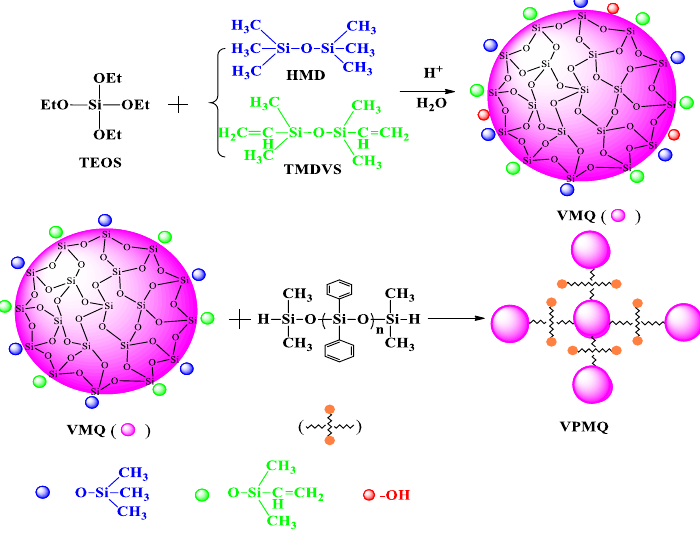
Figure 1. Synthesis routine of the VPMQ .